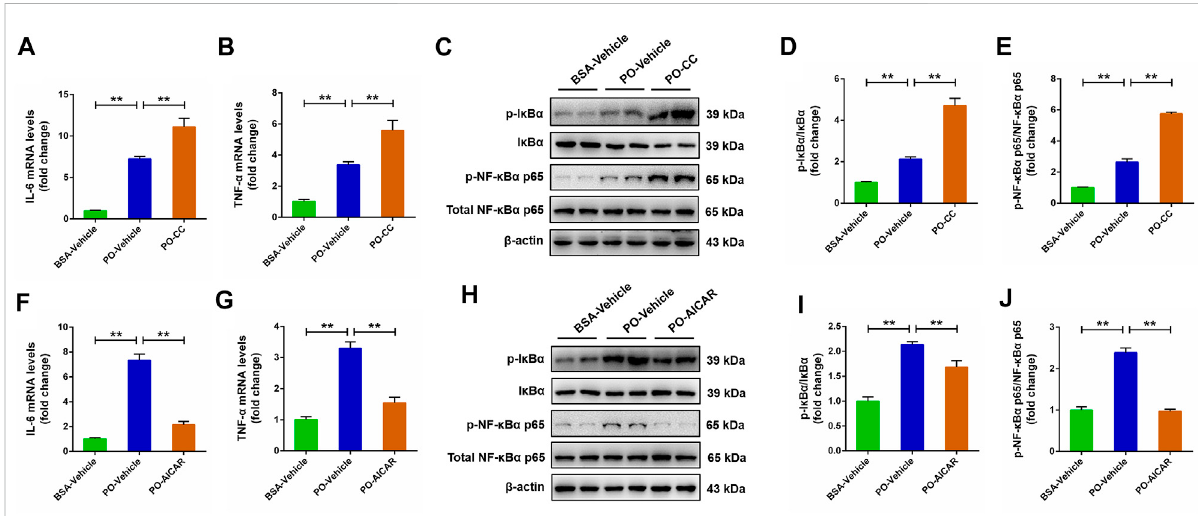
FIGURE 8 AMPK regulates pro-in fl ammatory mediator expression level and NF- κ B signaling pathway in PO-stimulated primary chicken hepatocytes. The primary chicken hepatocytes were pre-treated with/without 10 μ M AMPK inhibitor compound C for 1 h, and then stimulated with/without 0.75 mmol PO for another 24 h. (A) Interleukin 6 (IL-6) mRNA levels; (B) Tumor necrosis factor α (TNF- α ) mRNA levels; (C) Immunoblot of phospho ( p )-I κ B α , I κ B α , p-NF- κ B α p65 and NF- κ B α p65; (D) Statistical analysis of p-I κ B α /I κ B α ; (E) Statistical analysis of p-NF- κ B α p65/NF- κ B α p65. The primarychickenhepatocyteswerepre-treatedwith/without1 mMAMPKactivatorAICARfor1h,andthenstimulatedwith/without0.75 mmolPOfor another 24 h. (F) IL-6 mRNA levels; (G) TNF- α mRNA levels; (H) Immunoblot of p-I κ B α , I κ B α , p-NF- κ B α p65 and NF- κ B α p65; (I) Statistical analysis of p-I κ B α /I κ B α ; (J) Statistical analysis of p-NF- κ B α p65/NF- κ B α p65. * p < 0.05 and ** p < 0.01, signi fi cantly different between the indicated treatment